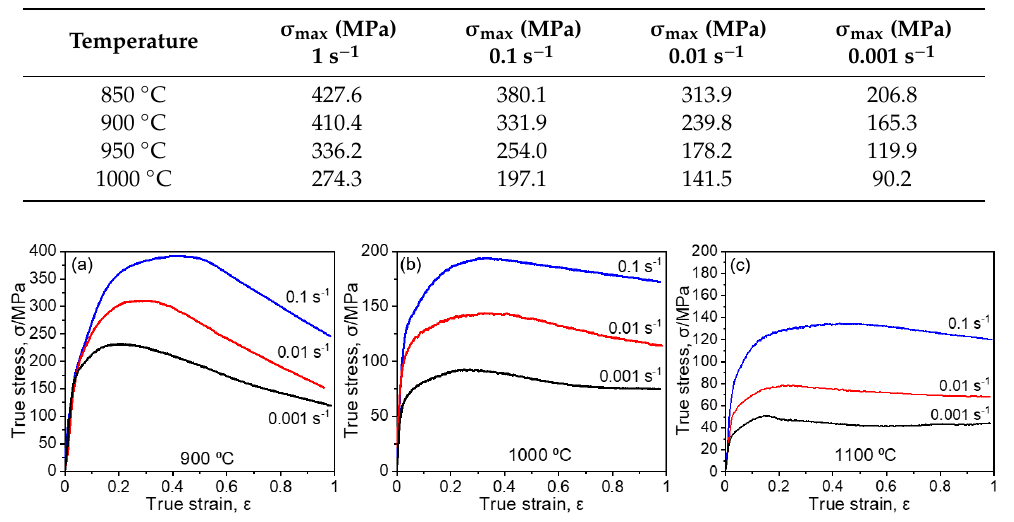
Figure 2. True stress-strain curves of the CoCrNi alloy hot-compressed at ( a ) 850 °C, ( b ) 900 °C, ( c ) 950 °C, and ( d ) 1000 °C. The strain rate is 1, 0.1, 0.01 and 0.001 s − 1 . Table 1. The peak stress ( σ max ) of the CoCrNi alloy hot-compressed at 850, 900, 950 and 1000 °C, respectively. The strain rate is 1, 0.1, 0.01 and 0.001 s − 1 .